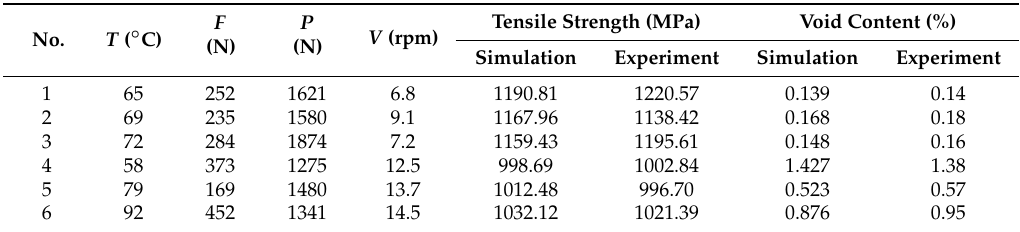
Table 9. Experimental verification of optimized